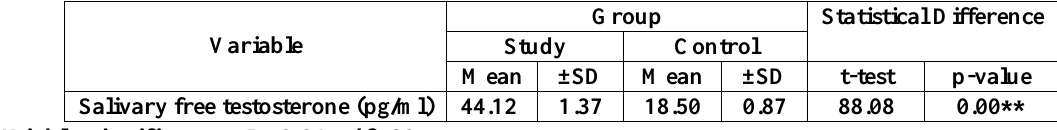
Table 2: Salivary free testosterone (mean±SD) among the study and control